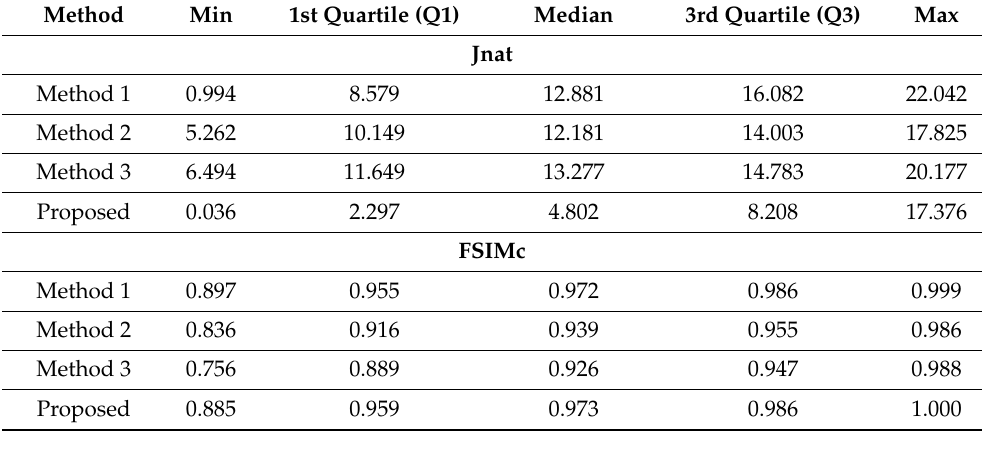
Table 4. Descriptive Statistics of the Jnat and FSIMc indices for the protanopia case considering the McGill’s Flowers and Fruits data sets (in total 195 images).